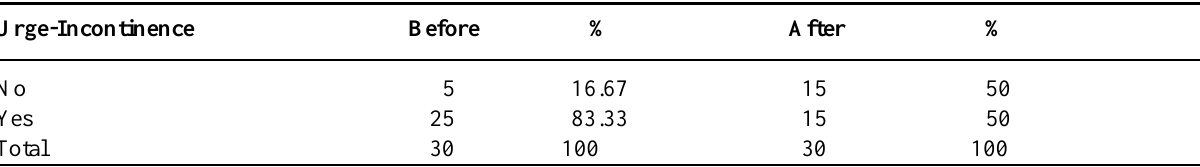
Table 3 – Resiniferatoxin effect on urge-incontinence.